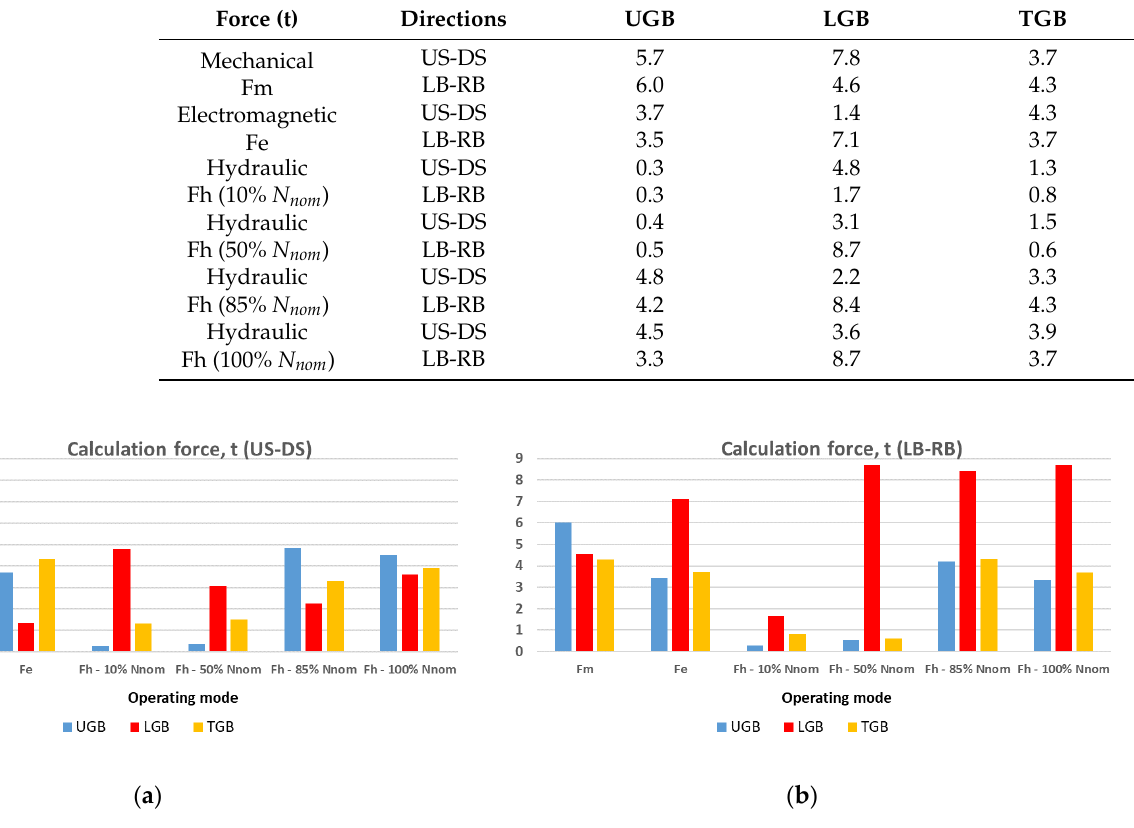
left bank-right bank direction (LB-RB); Fm — mechanical force, Fe — electromagnetic force, Fh — hydraulic force with indication of relative power.